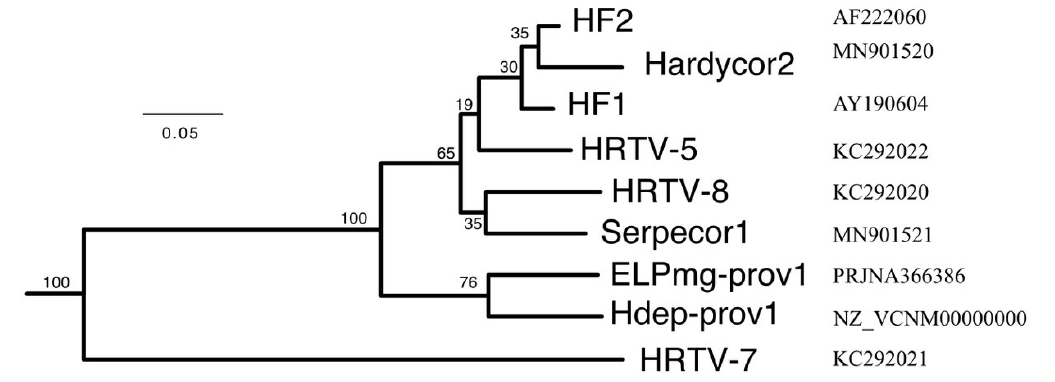
Figure 7. Phylogenetic tree reconstruction of viruses inferred from protein sequences using the Genome-BLAST Distance Phylogeny method (GBDP) under optimal settings (formula VICTOR d 6 ), as implemented at the DSMZ webserver https://victor.dsmz.de. Percentage support values are shown at branch points. The branch lengths are scaled in terms of the GBDP distance formula d 6 [17]. Tree scale (0.05) is indicated by the bar. Accessions are given at the right. For details of strains and proviruses, see Table 2.